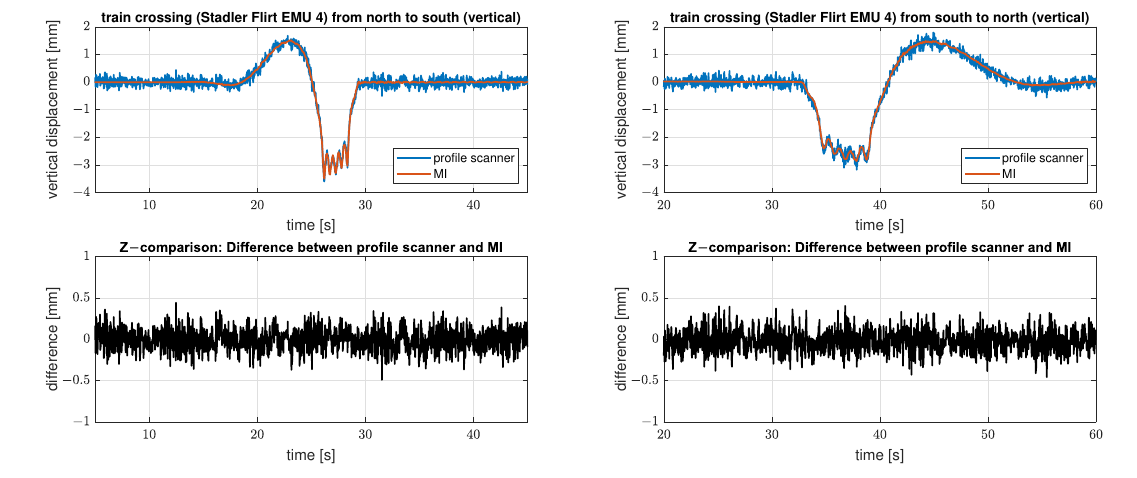
Figure 10. Comparison of the derived displacements with both measuring systems (profile scanner and MI) at cross girder 6. Line 1 shows the measurements of the IMAGER 5016 in profile mode in blue and the IBIS-S measurements in red (no projection necessary) and line 2 displays the respective differences in black.